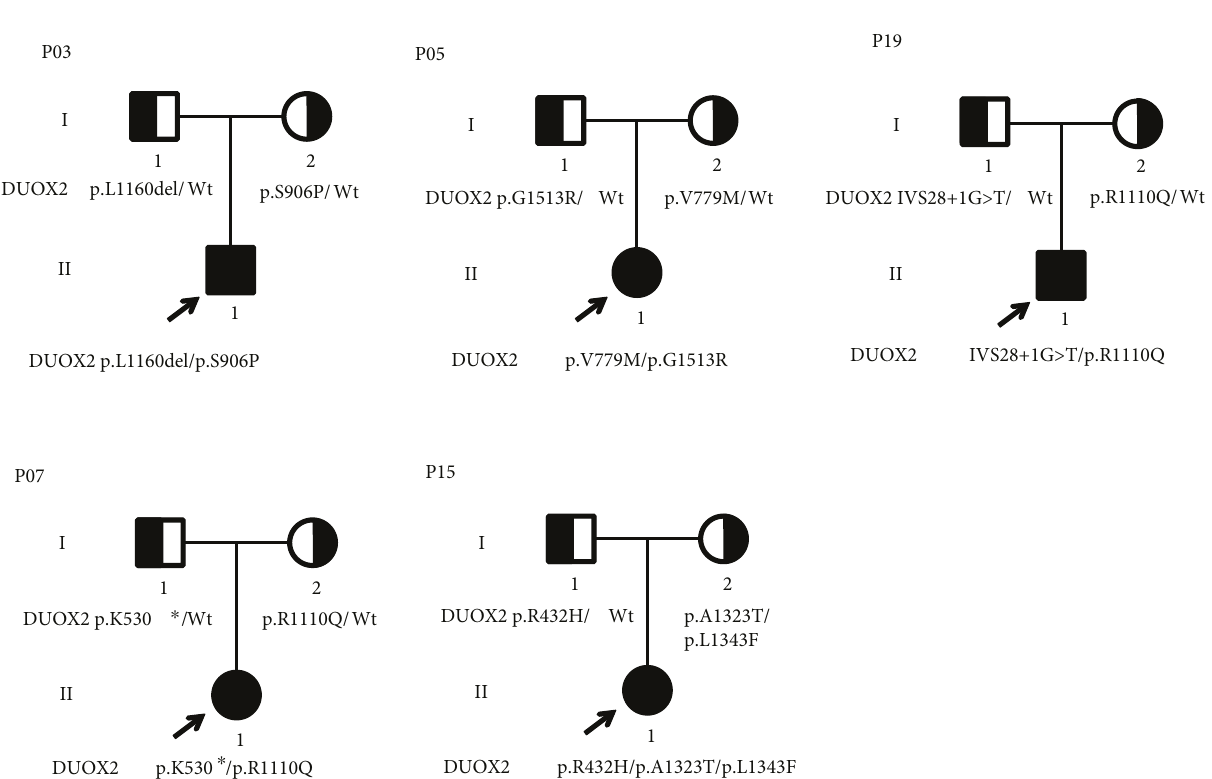
Figure 3: Genotypes and pedigrees of fi ve DH patients. Arrow: proband; Roman numbers: generations; squares: males; circles: females; half- fi lled symbols: una ff ected heterozygote